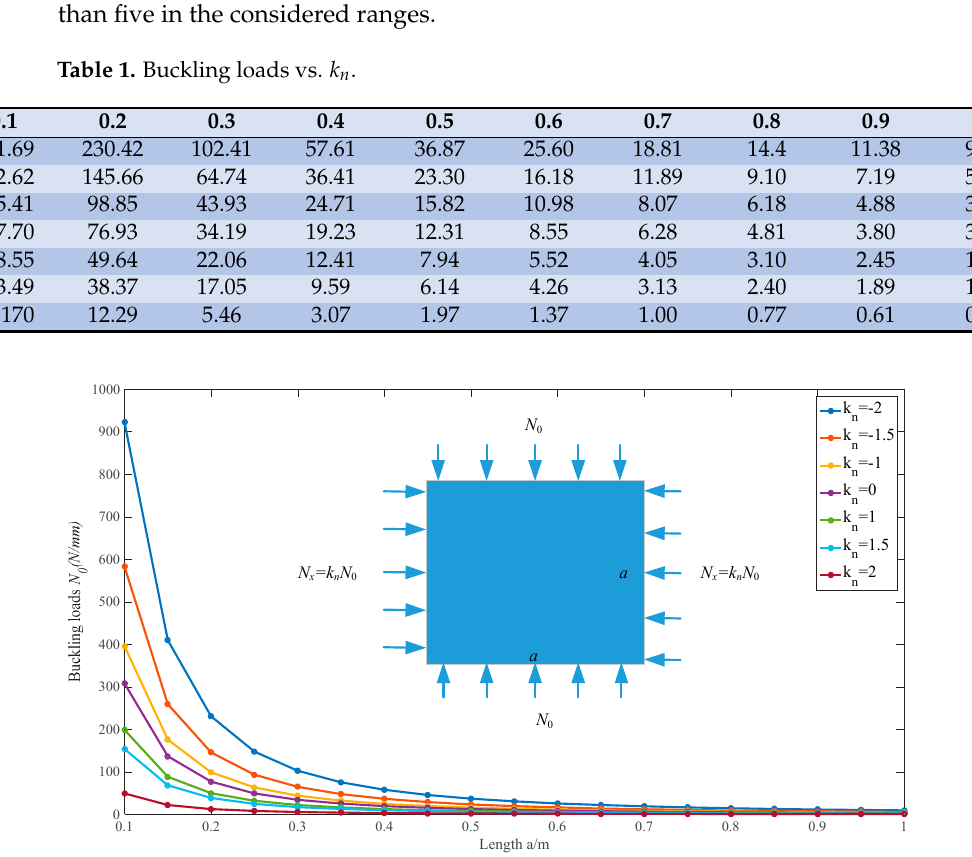
Figure 2. Buckling loads affected by axial force parameter.